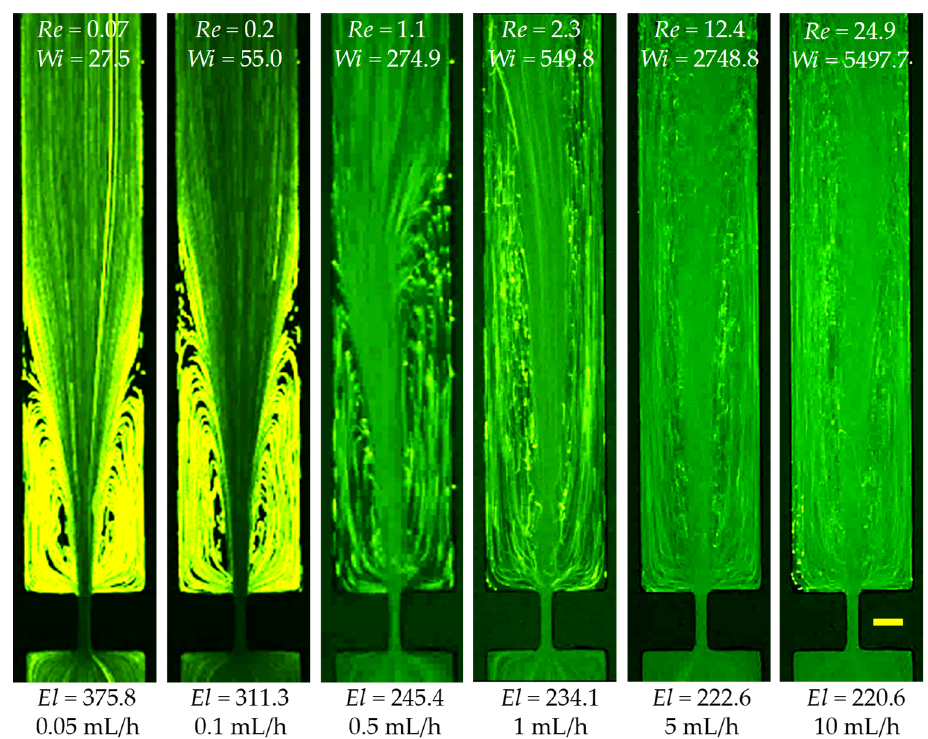
Figure 7. Inertialess ( 𝑅𝑒 < 0.1 ) or inertial flow (downward) of 200 ppm highly elastic and highly shear thinning PAA solution at the contraction–expansion region of the microchannel. The scale bar represents 100 µm.